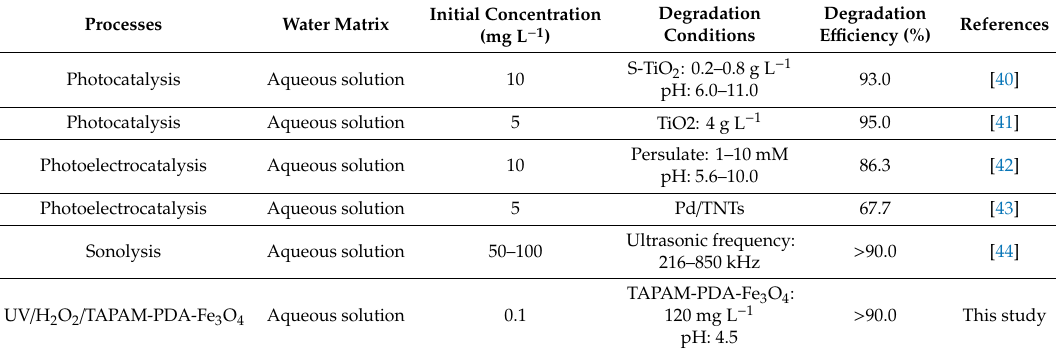
Table 4. Comparison of the diclofenac sodium degradation by di ff erent